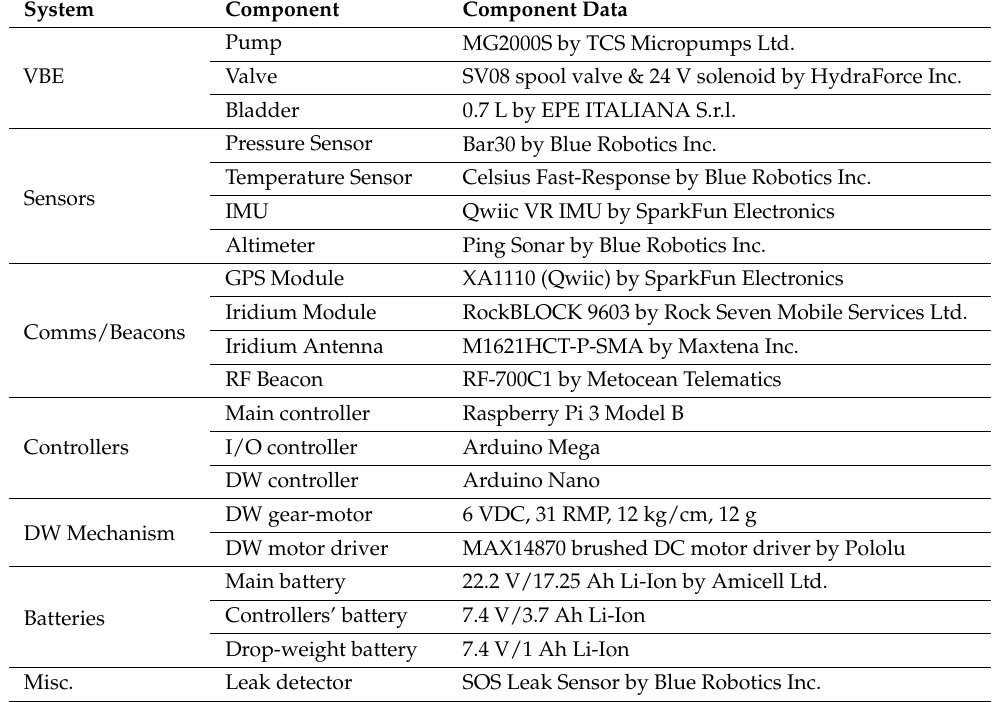
Table 2. Main float